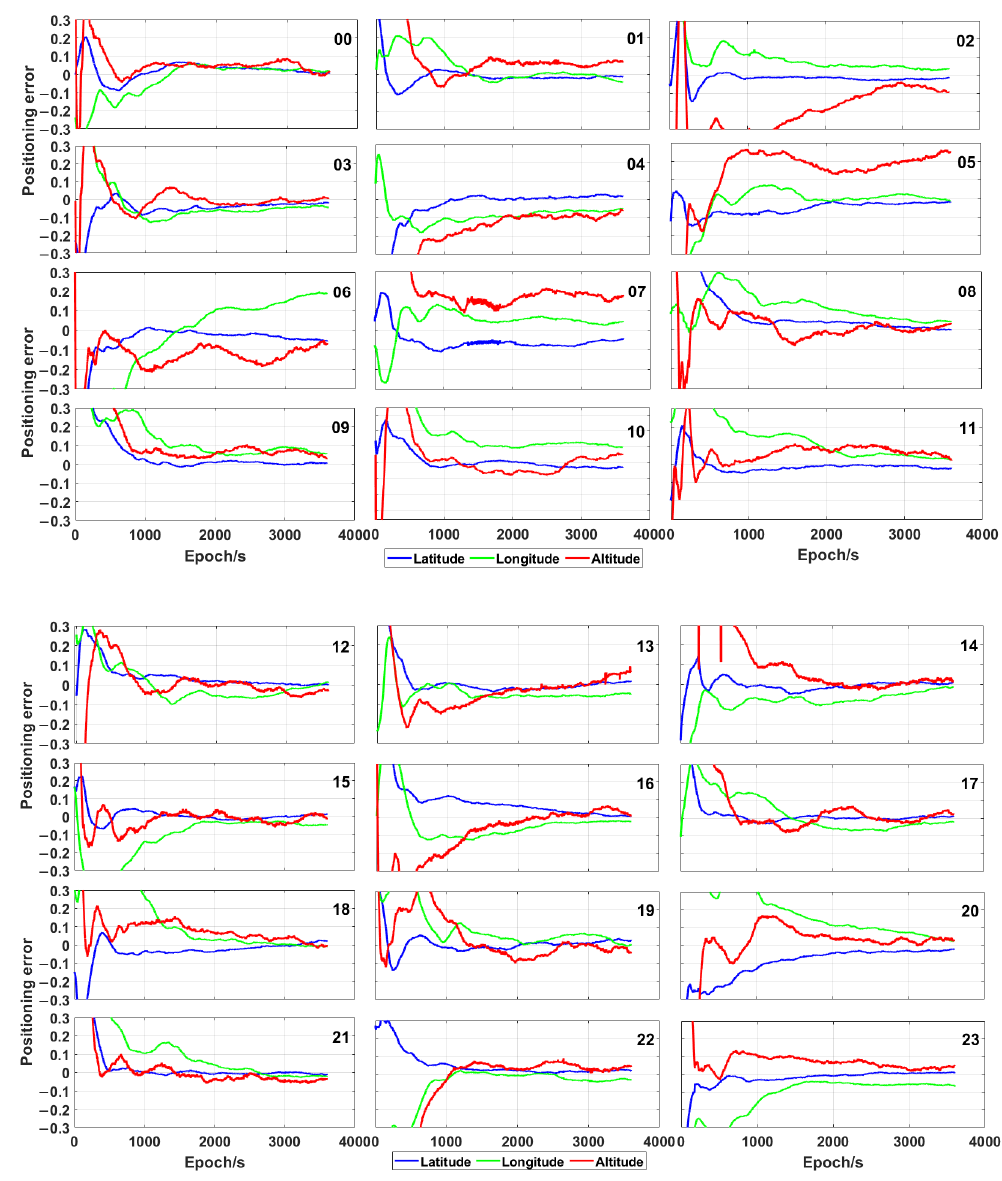
Figure 8. Precise point positioning (PPP) error (expressed in metres) obtained by using GPS/Galileo/BeiDou satellites and CNT (a product of the Centre National d’Etudes Spatiales) at different times.